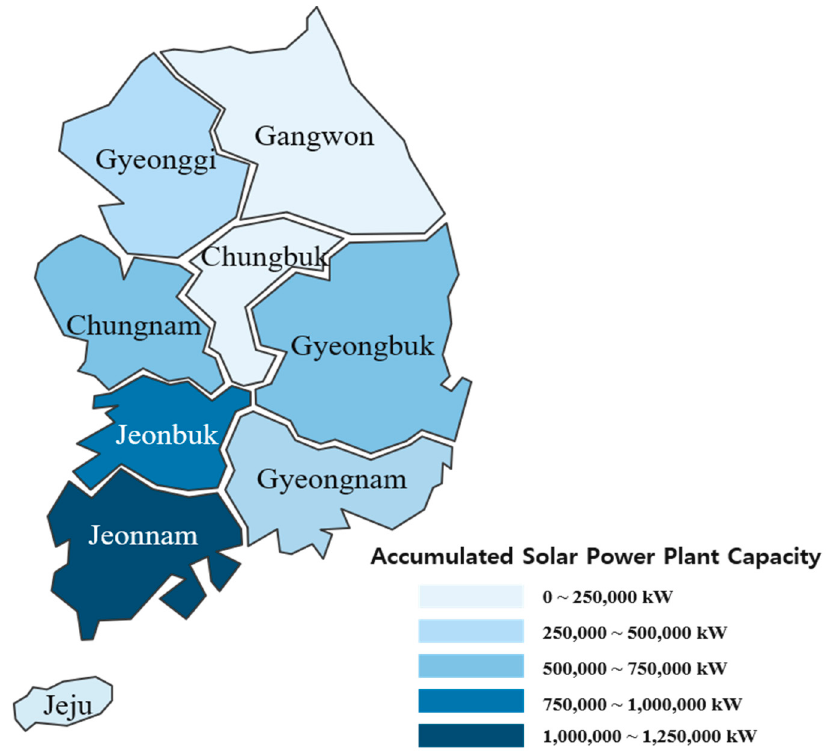
Figure 1. Korea’s accumulated capacity of photovoltaic power plants in 2017.